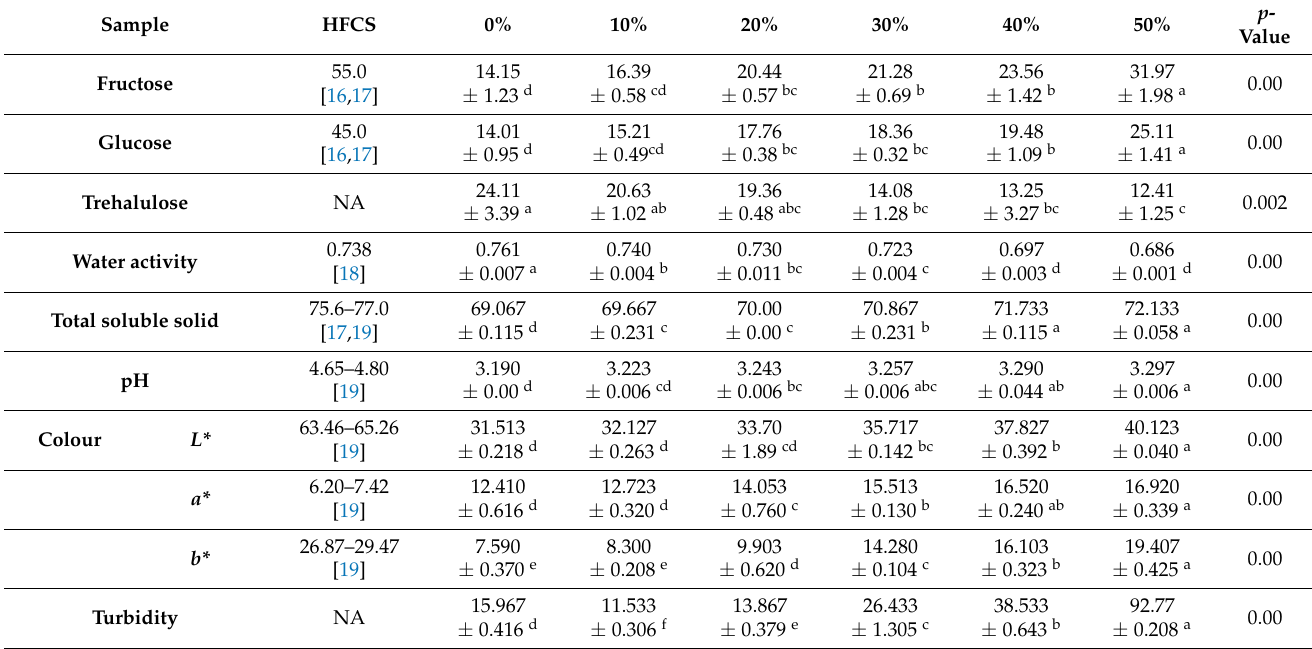
Table 1. Physicochemical characteristics of Kelulut honey adulterated with HFCS at different